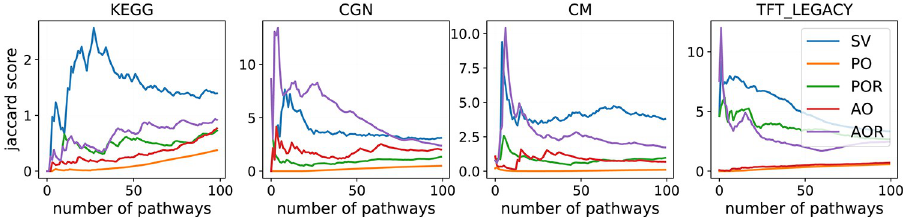
Fig 2. Redundancy awareness. In the plots: average re-scaled Jaccard scores of sets of pathways ranked up to j -th position ( x axis). In each of the collection of gene sets, we select up to 100 pathways. In the table: re-scaled Jaccard rates of the first 10, 20 and 40% of the gene sets; In each column, underlined text indicates the minimum Jaccard score.